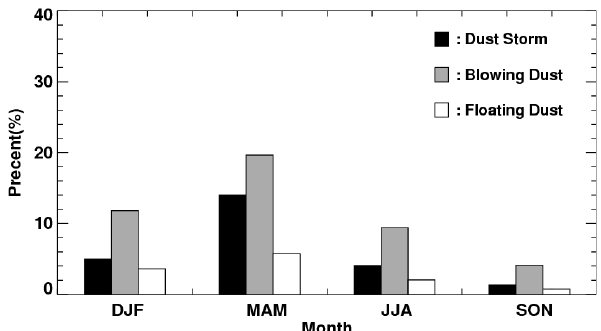
Fig. 3. Dust event category frequency of occurrence for the selected regions. Dust storm (DS) is shown in the black bars, blowing dust (BD) is shown with grey bars, and floating dust (FD) is shown by the white bars.